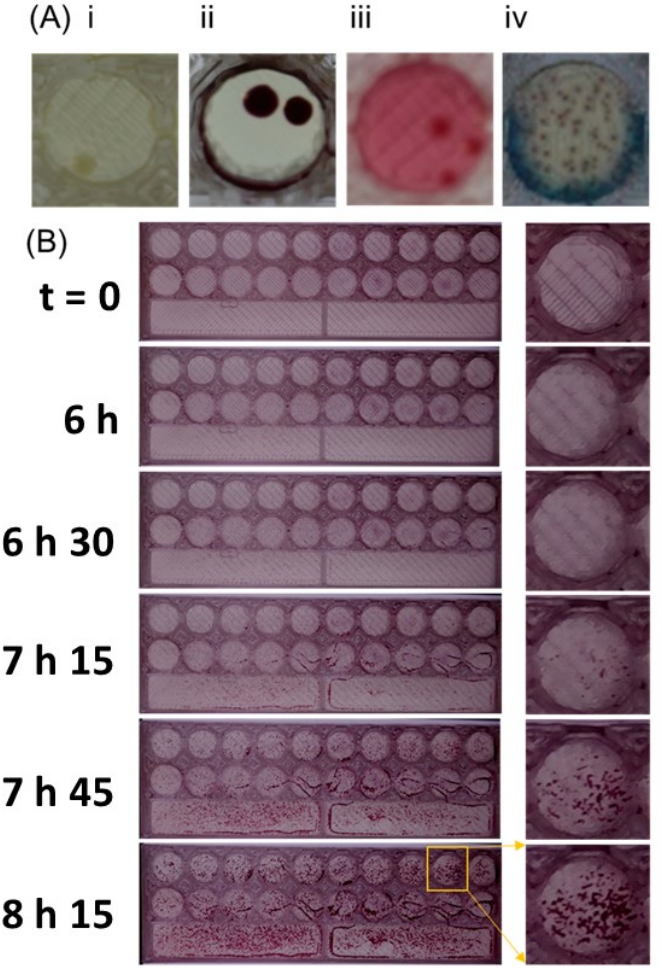
Figure 4. Different media appearance and kinetics of growth on millifluidic solid microbiological media . ( A ) The appearance of colonies on 6 mm 3D-printed discs containing the following agar types: Muëller–Hinton Agar (MHA) (i), MHA with triphenyl tetrazolium chloride (TTC) dye added (ii), MacConkey (iii), and CHROMagar™ Mastitis Gram – (iv). ( B ) Selected timepoints from time-lapse analysis of colony growth, showing the emergence of colonies around 7–8 h on MHA with TTC. 3.3. Detection of Individual Bacteria Isolates and Their Antibiotic Resistance Profile Three-dimensional (3D)-printed dip slides with sets of miniaturized 6 mm diameter dip-slide wells plus rectangular identification strips were compared to conventional broth microdilution for the capacity to detect individual strains and measure their antibiotic susceptibility. Antibiotics such as Ampicillin, Amoxicillin, Amikacin, Ceftazidime, Cefo- taxime, Ofloxacin, Oxytetracycline, Streptomycin, Gentamycin and Imipenem were used for this purpose, with Figure 5 showing images with four representative antibiotics. There was an agreement of MIC results between our dip slide to broth dilution methods. Next, bacterial isolation was compared between the agar dish and miniaturized dip slides with specific agar media—Mackonkey agar (MC) and CHROMagarTM Mastitis